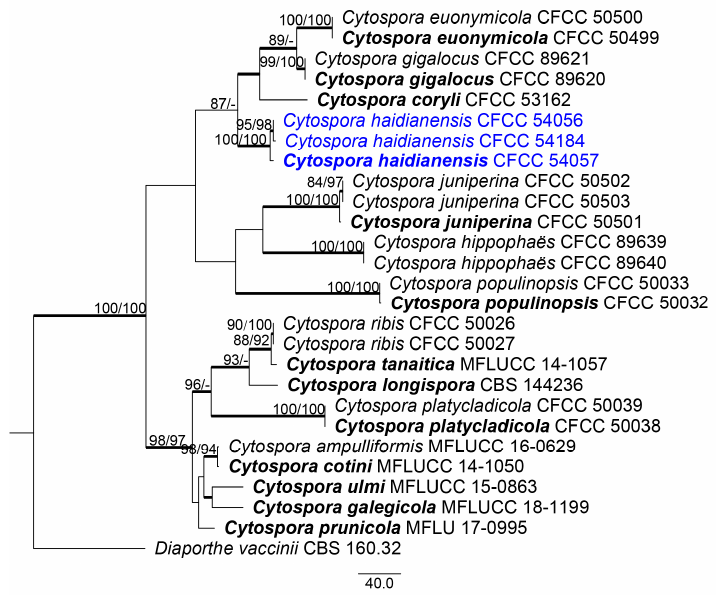
Figure 2. Phylogram of the best-parsimonious tree of Cytospora based on combined ACT, ITS, RPB2, TEF1- α and TUB2 genes. MP and ML bootstrap support values above 70% are shown at the first and second positions, respectively. Thickened branches represent posterior probabilities from BI above 0.95. Scale bar = 40 nucleotide substitutions. Diaporthe vaccinii CBS 160.32 was used as the outgroup. Ex-type strains are in bold. Strains from the current study are in bold and blue.